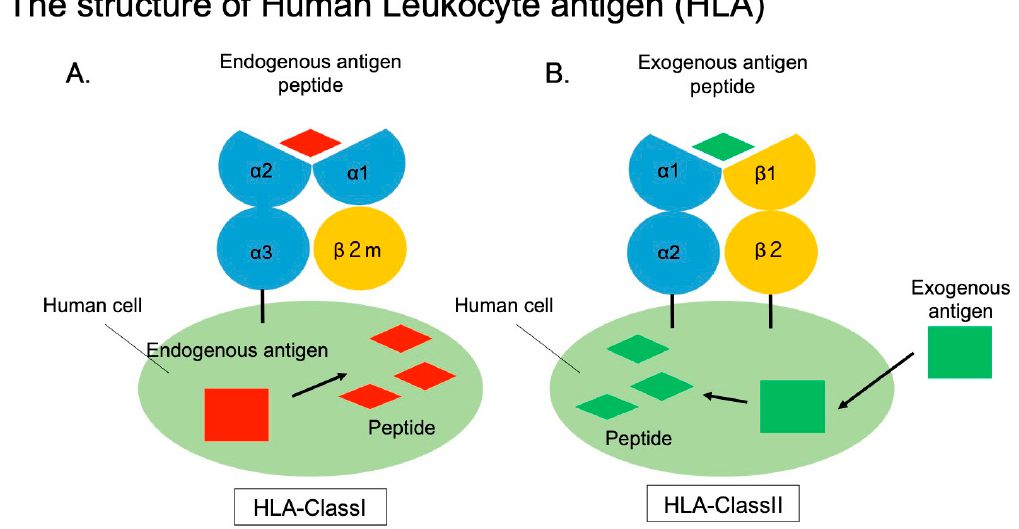
Figure 2. A . Structure of HLA class I molecules. Endogenous antigens such as tumor cells and infected cells are presented as peptide. B . HLA class II structure. Exogenous antigens taken up by phagocytic cells are presented as